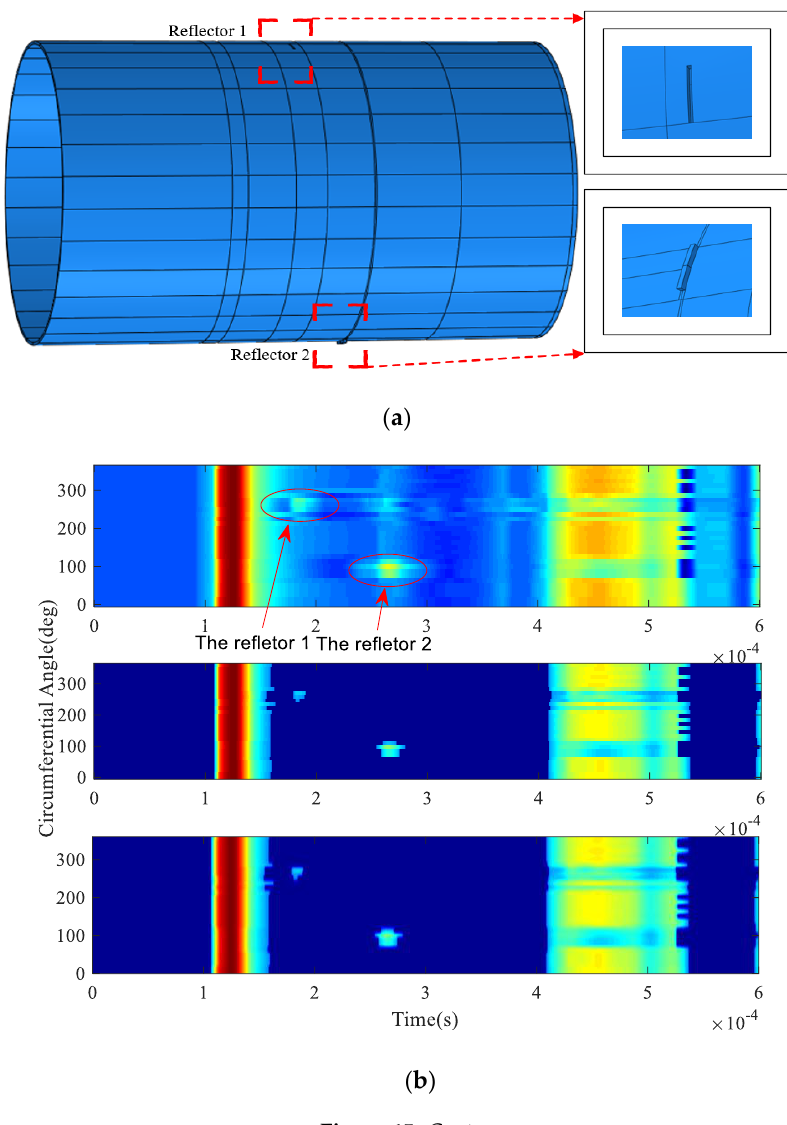
Figure 14. Analysis results based on the proposed method:( a ) original 2D scanned image ( Up ), enhanced 2D scanned image ( Middle ) and smoothed 2D scanned image ( Down ); ( b ) enhanced 2D scanned binary image; ( c ) distance curves Ψ 1 ( Up ) and Ψ 2 ( Down ); ( d ) updated judgment results to the enhanced 2D scanned binary image with different